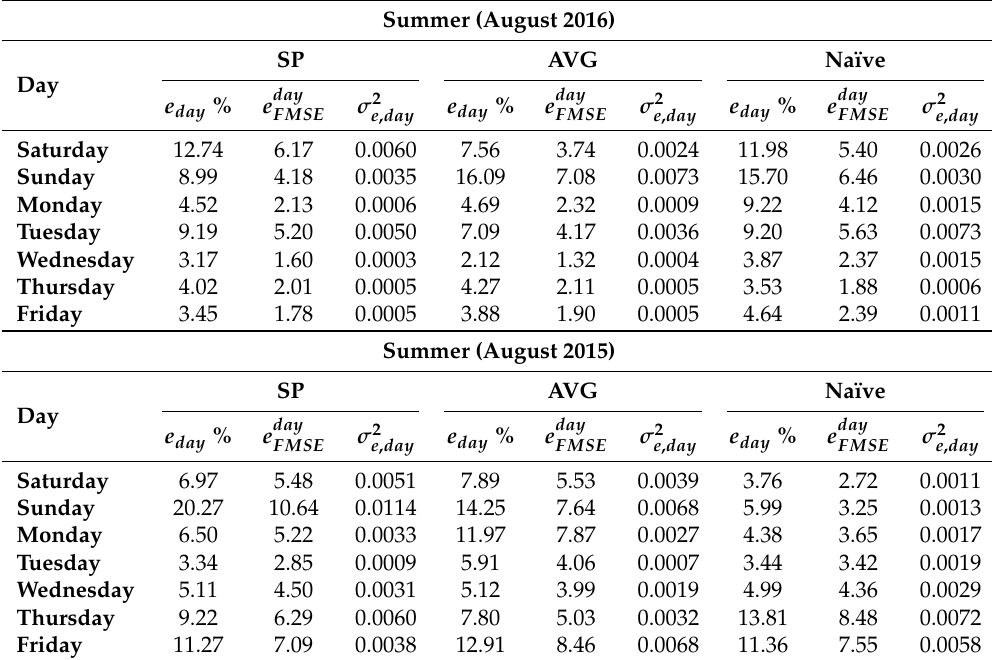
Table 9. e day (%), e day and naïve